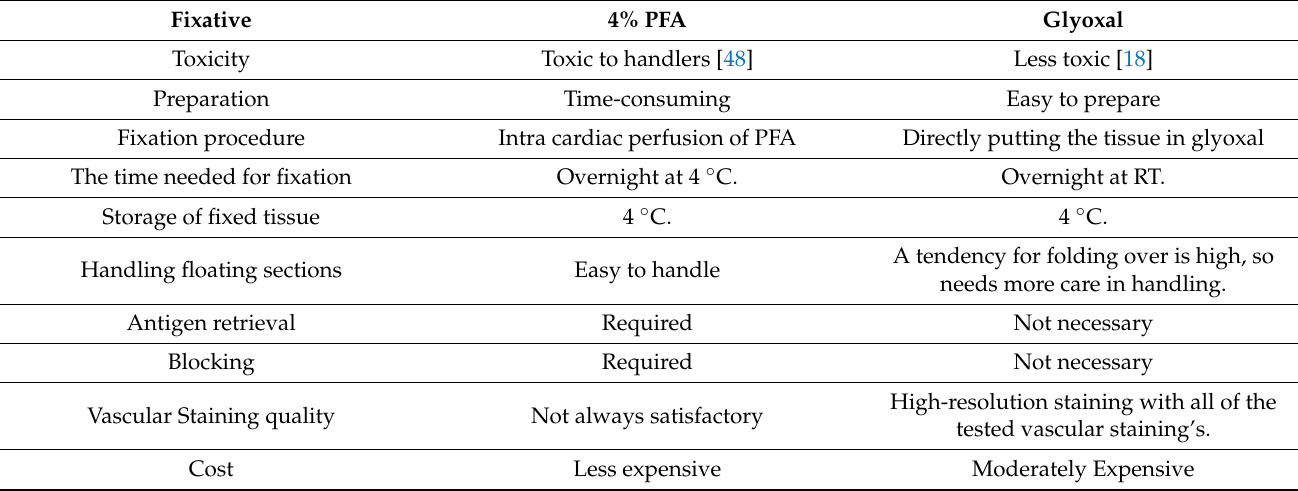
Table 1. Comparison 4% PFA vs. Glyoxal